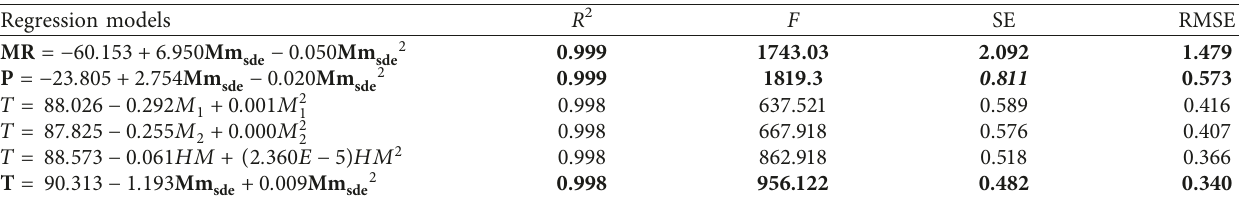
Table 9: The quadratic regression models that give the best estimation for the molar refractivity (MR), the polarizability (P), and the surface tension (T). Regression models